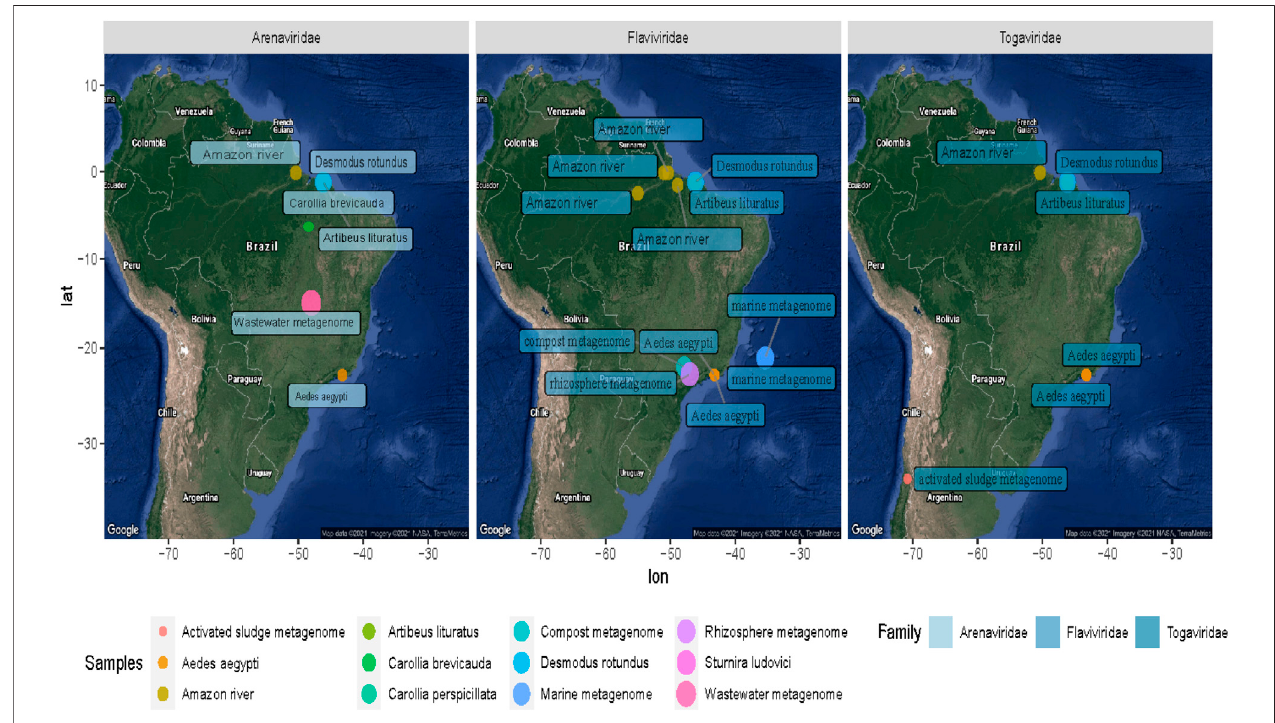
FIGURE 4 | Correlatogram between the assigned family frequency distributions in the metagenomes obtained with all the methods used.